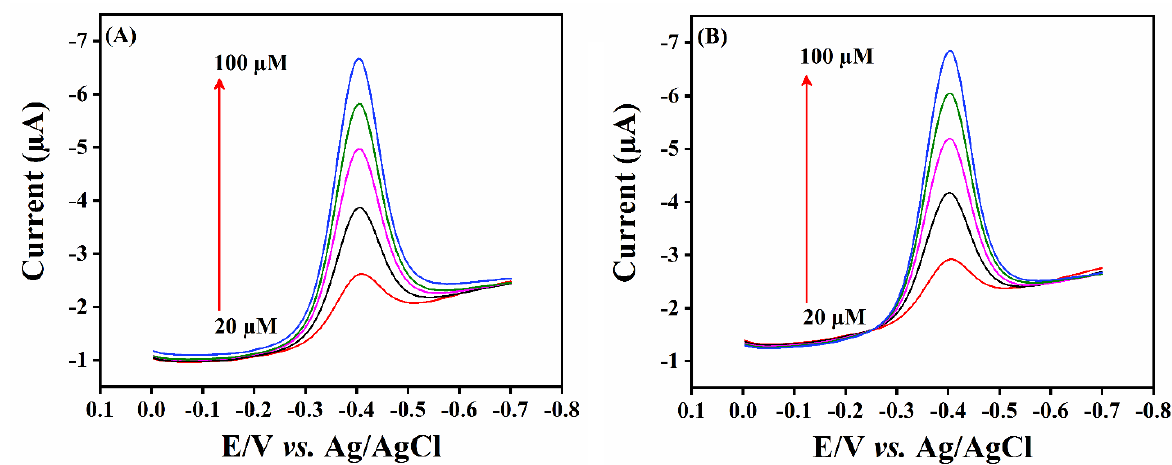
Table 2. Practicality of FLD detection in spiked human urine and wastewater samples ( n = 3).